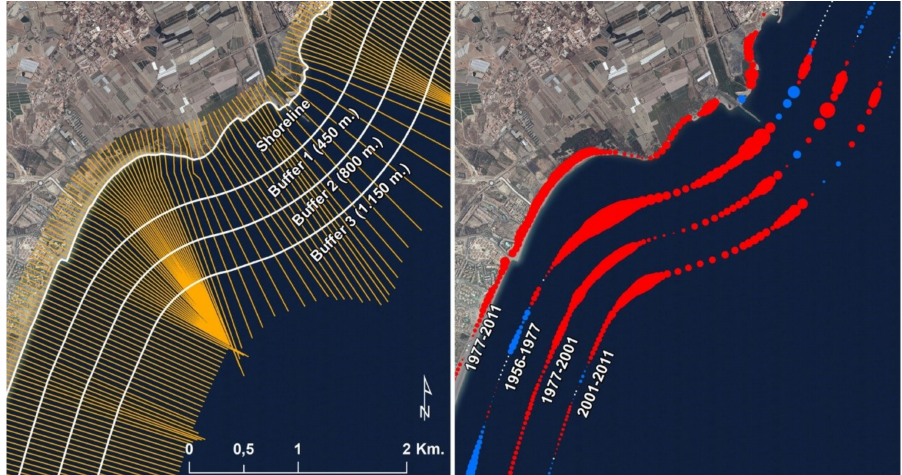
Figure 6. Representation of erosion rates on point